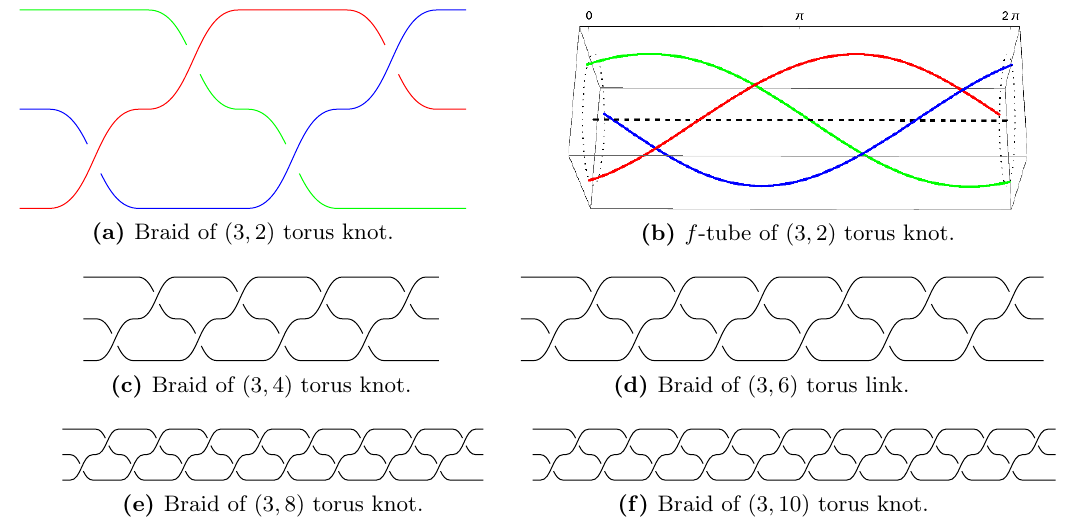
Figure 8. The braid and the f -tube presentation for the type III (cid:12)ber with a = 1. b =